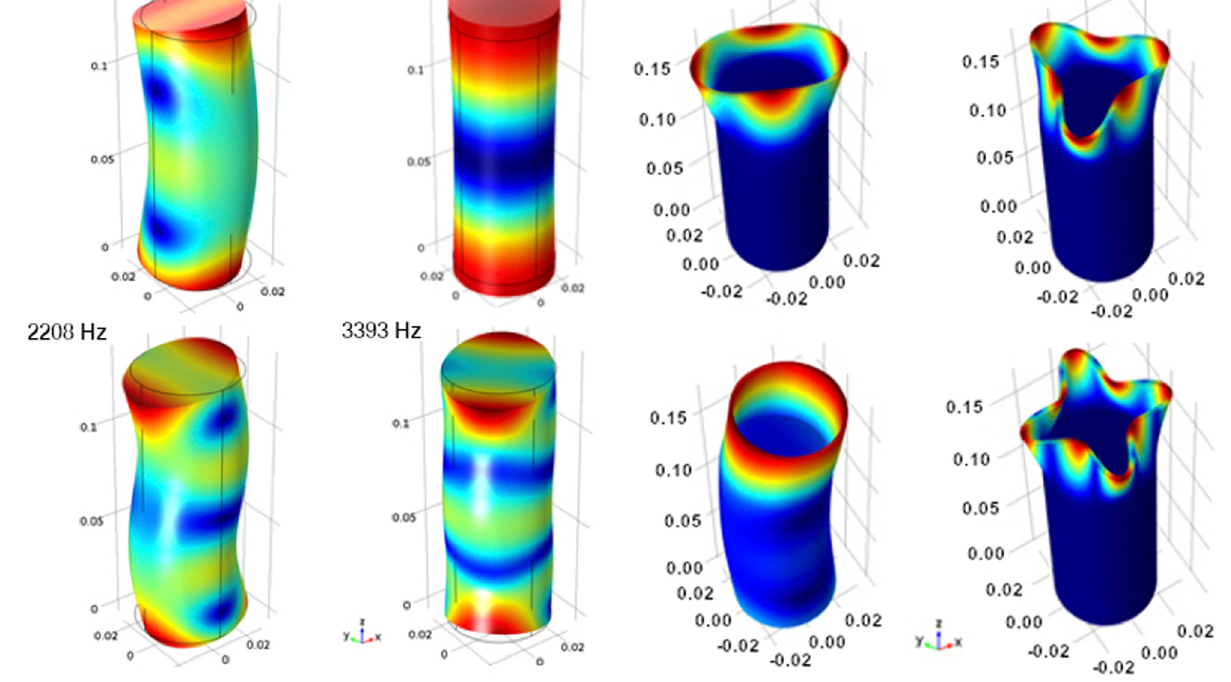
Figure 16: Calculated natural frequencies for specimens without sleeve. The test bodies have a length of 130.7 mm.